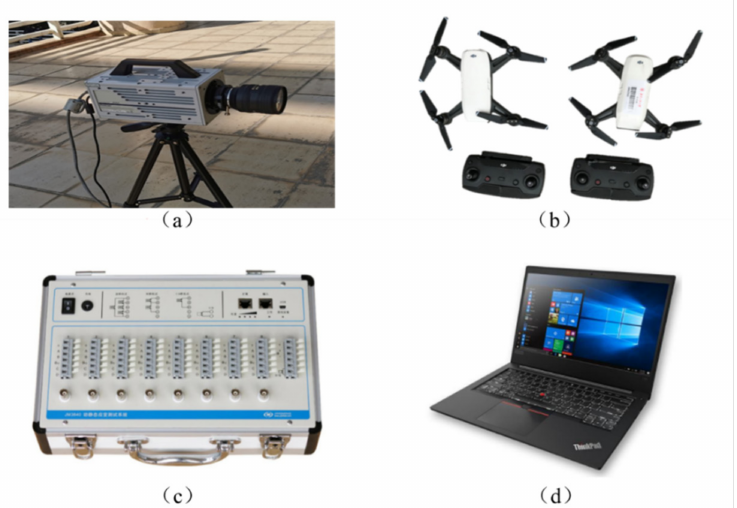
Figure 5. Experimental equipment: ( a ) Fixed camera; ( b ) DJI drone; ( c ) JMTEST acquisition instru- ment; ( d ) JMTEST dynamic acquisition